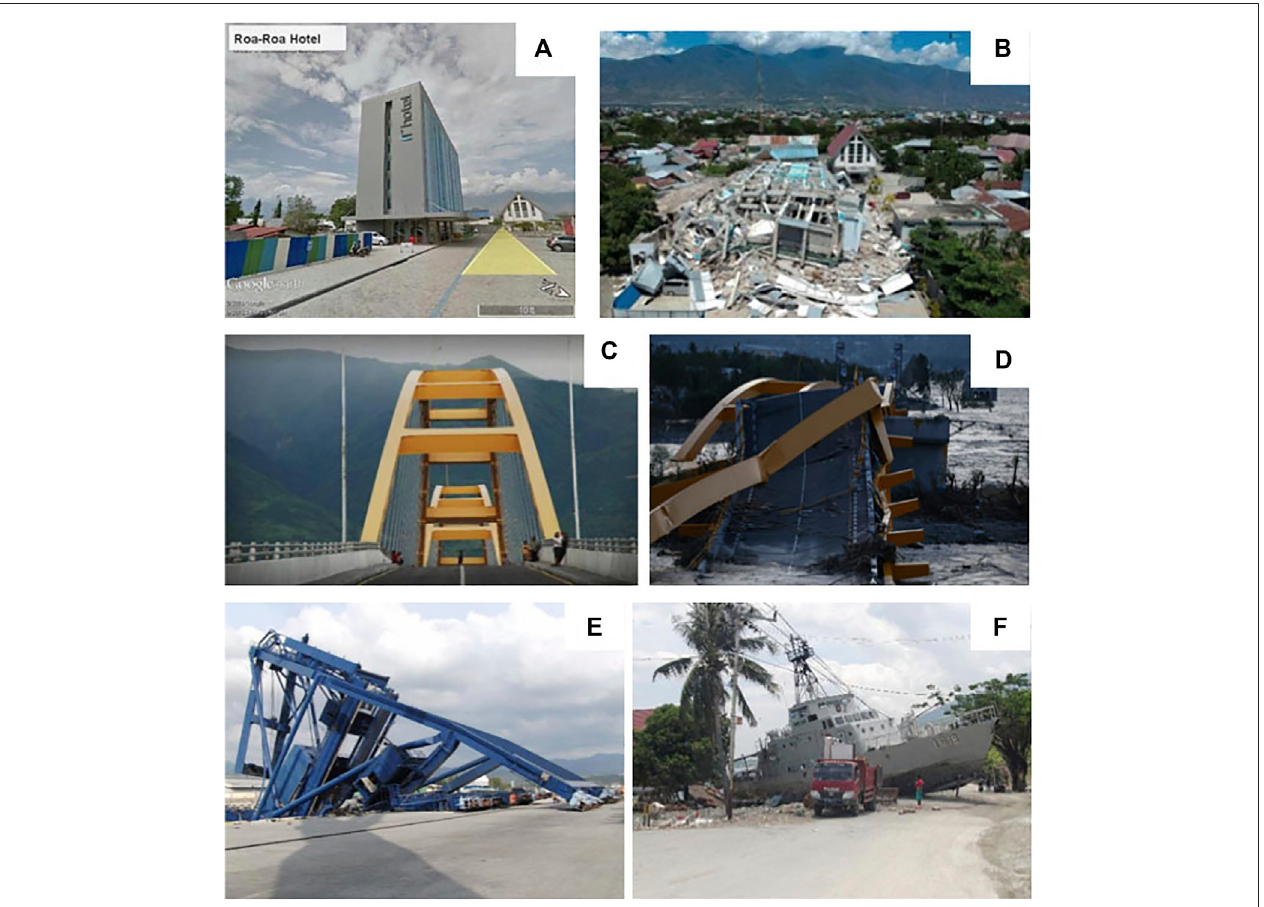
FIGURE 6 | Damage induced by the Palu Earthquake and Tsunami: Roa-Roa Hotel in Palu, built in 2013, ( A ) before the earthquake and ( B ) after the earthquake, steel double arch Palu Bridge IV over the mouth of the Palu River ( C ) before the earthquake and ( D ) after the earthquake and tsunami; ( E ) collapse of gantry crane in the Port of Pantoloan due to earthquake shaking; ( F ) naval ship washed ashore at Watusampu Naval Base.